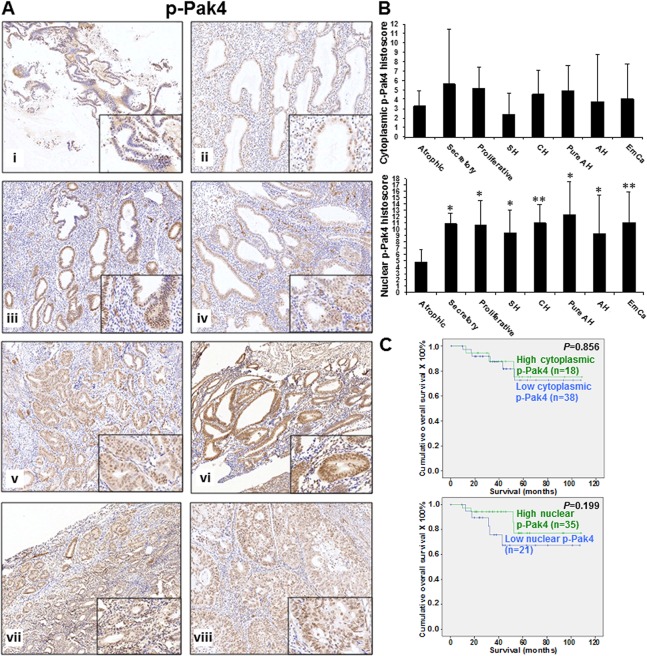
(A) p-Pak4 immunoreactivity in normal atrophic endometrium (i), secretory endometrium (ii), proliferative endometrium (iii), simple hyperplasia (iv), complex hyperplasia (v), pure atypical hyperplasia (vi), atypical hyperplasia (vii) and endometrial cancers (viii). (B) Bar chart showing the immunoreactivity of cytoplasmic (upper panel) and nuclear (lower panel) p-Pak4 in normal atrophic endometrium (Atrophic), secretory endometrium (Secretory), proliferative endometrium (Proliferative), simple hyperplasia (SH), complex hyperplasia (CH), pure atypical hyperplasia (Pure AH), atypical hyperplasia (AH) and endometrial cancers (EmCa). *, P<0.05; **, P<0.005; compared to normal atrophic endometrium by Mann-Whitney test. (C) Kaplan-Meier survival curves for endometrial cancer patients with two different expression levels of cytoplasmic (upper panel) and nuclear (lower panel) Pak4 (cut off at mean).